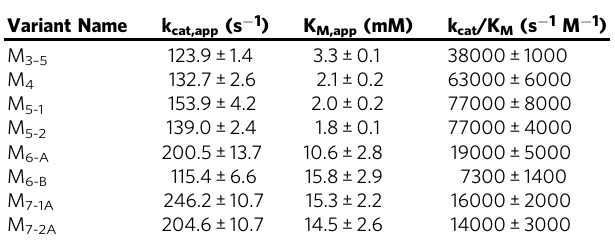
Table 2 Apparent kinetic parameters for GOase variants with